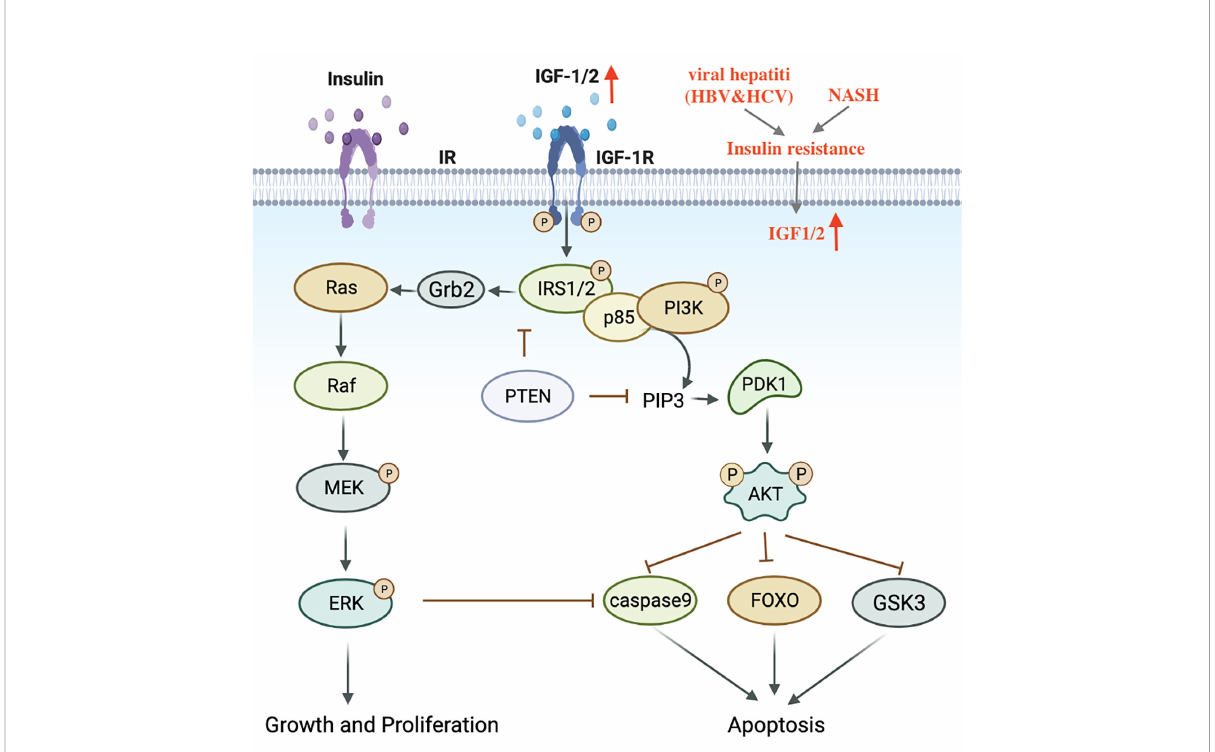
FIGURE 3 Transduction mechanism of the IGF1 signaling pathway in HCV, NASH-induced HCC. IGF, Insulin-like growth factor; IRS, Insulin receptor